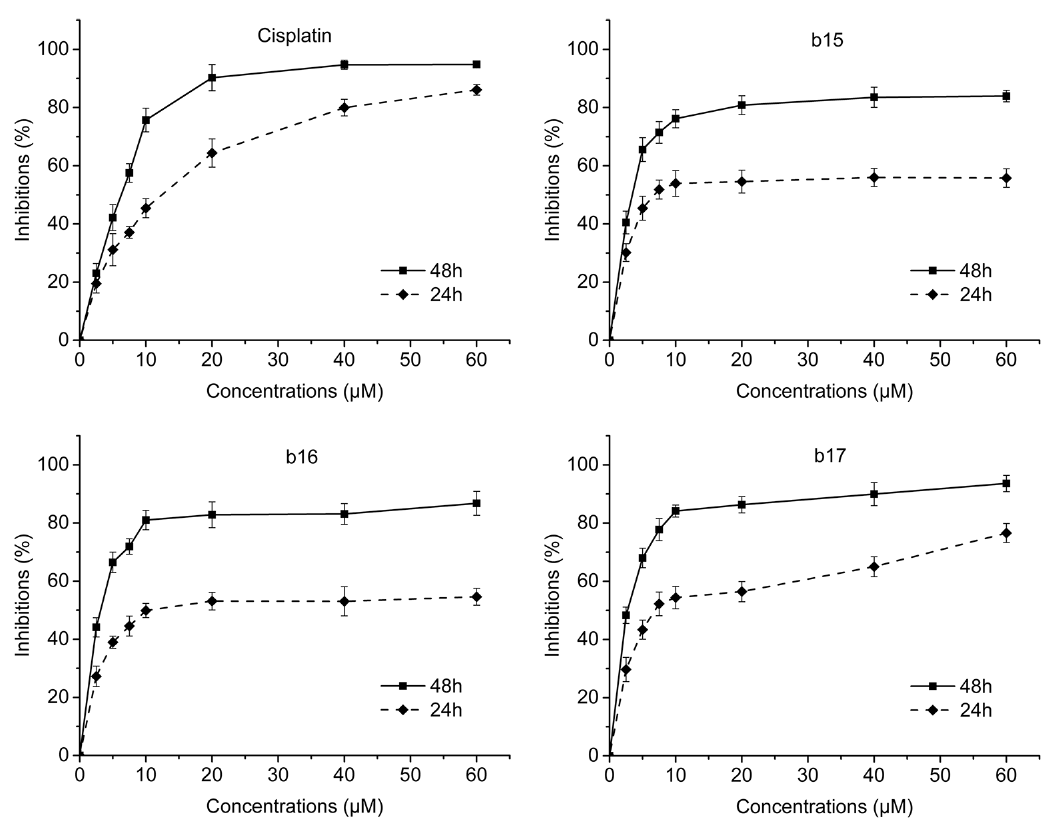
Figure 2. Inhibitory effects of compounds b15 – 17 and cisplatin on HepG-2 cells after 24 h and 48 h.